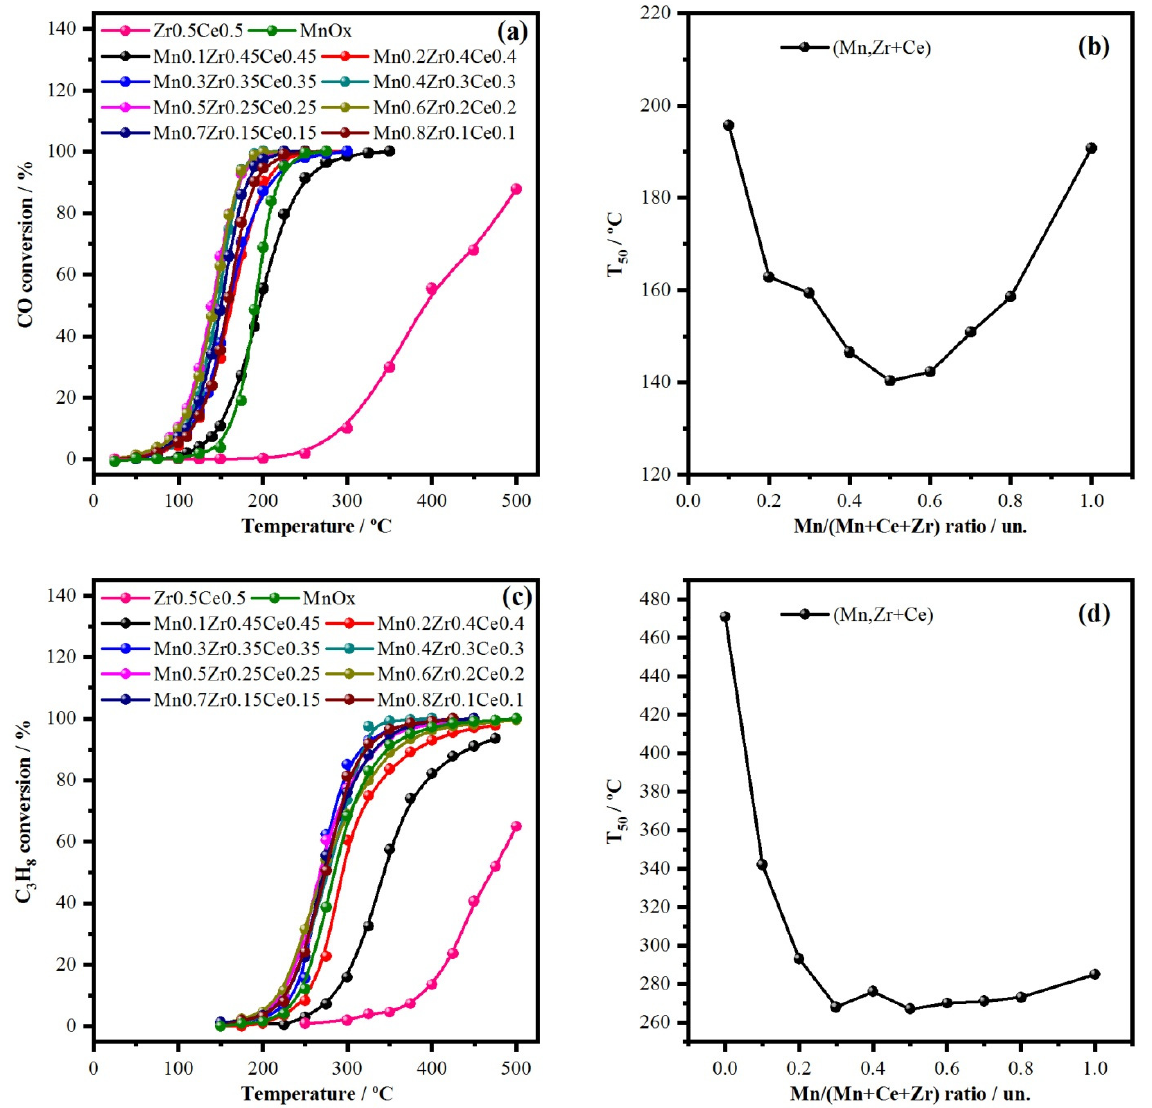
Figure 5. Reaction temperature dependence of ( a ) CO and ( c ) C 3 H 8 conversion; the molar ratio Mn/(Mn + Ce + Zr) dependence of T 50 for ( b ) CO and ( d ) C 3 H 8 conversion in oxidation reaction over Mn(x)Zr(0.5 − x/2)Ce(0.5 − x/2) catalysts.